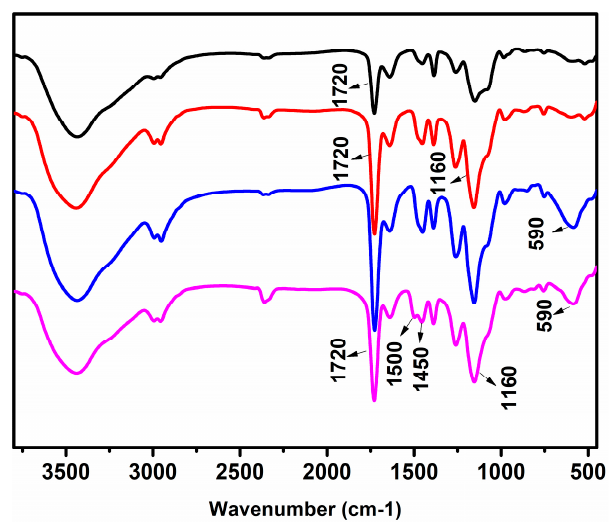
Figure 4. FTIR (Fourier Transform infrared spectroscopy) spectra of ( a ) PMMA; ( b ) PMMA–COOH; ( c ) PMMA@Fe 3 O 4 and ( d ) PMMA@Fe 3 O 4 @DR microspheres. Thermogravimetric analysis (TGA) curves of PMMA@Fe 3 O 4 @DR and the results are shown in